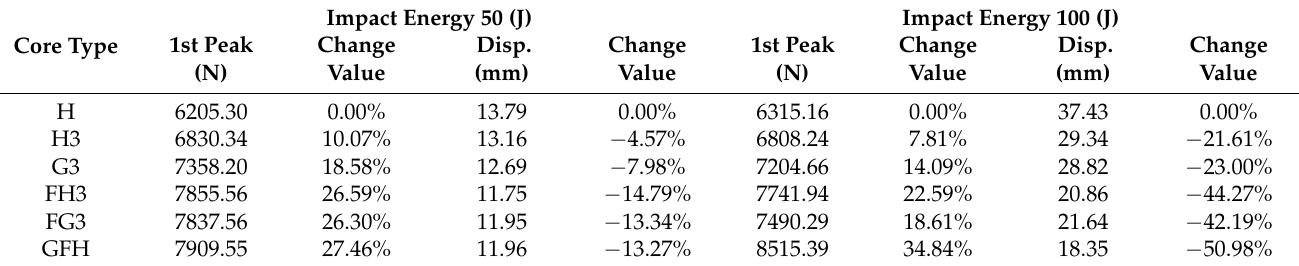
Table 4. Change values of sandwich panels under hemispherical impactor.